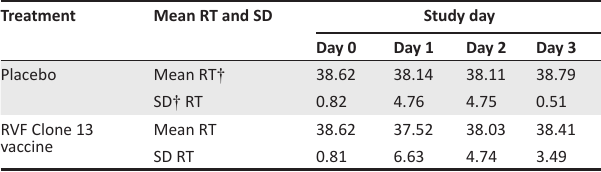
TABLE 3: Mean and standard deviations for rectal temperature in °C from day 0 to day 3. Treatment